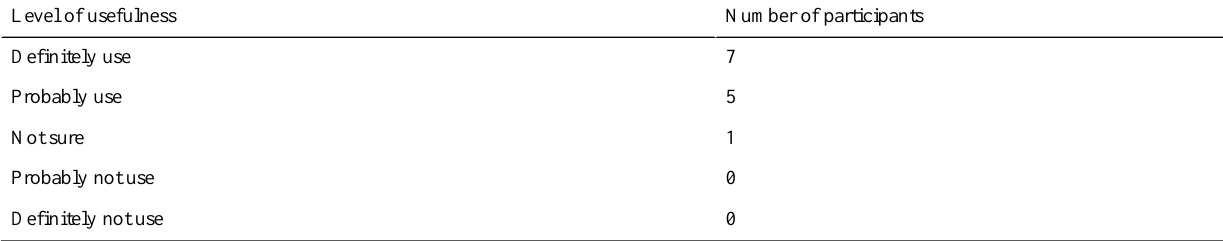
Table 7. Reported willingness to use PersonA when